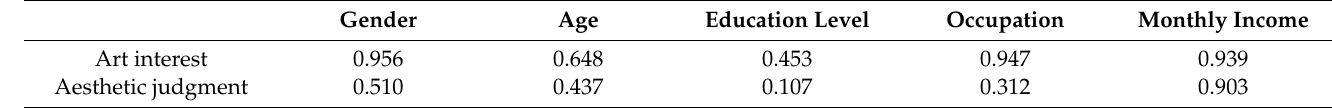
Table 2. Correlation analysis